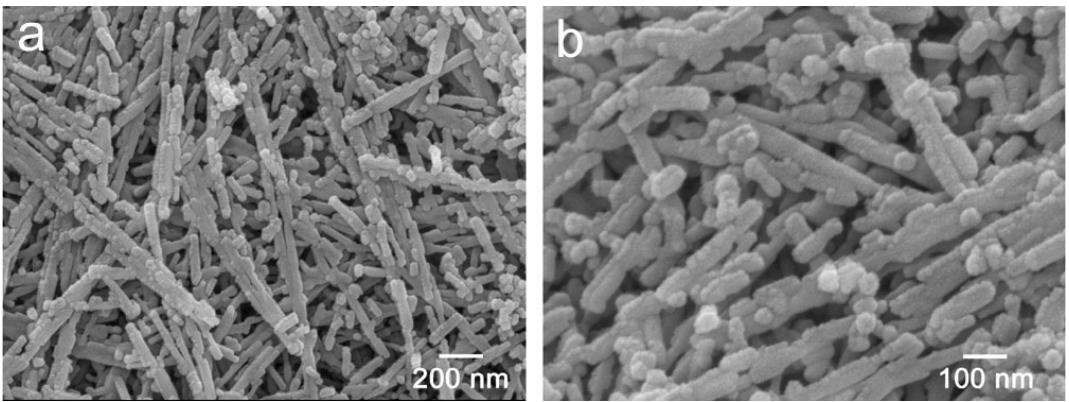
Fig. 7 SEM micrographs of the partially nanowire-structured TiO ◦ C for 4 h indicating the improved thermal stability of one-dimensional structure com- pared with the reported nanotube-structured TiO